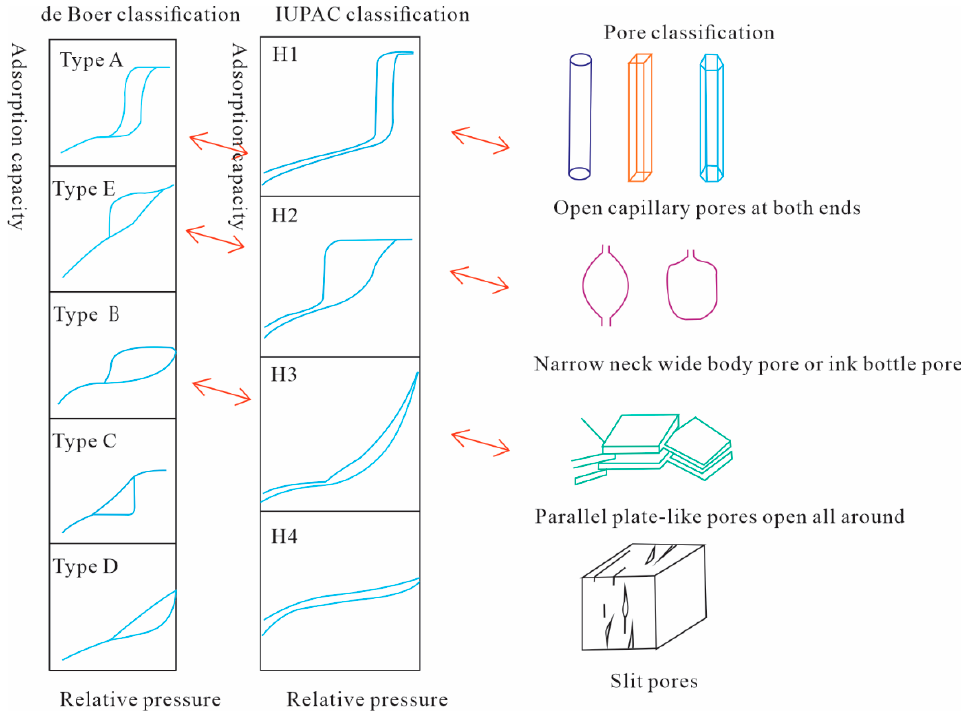
Figure 4. Classification of the nitrogen adsorption–desorption curves and the corresponding pore types [23,24]. Table 3. Experimental results of the LT-N 2 A on the low-rank coal samples under negative pressure.